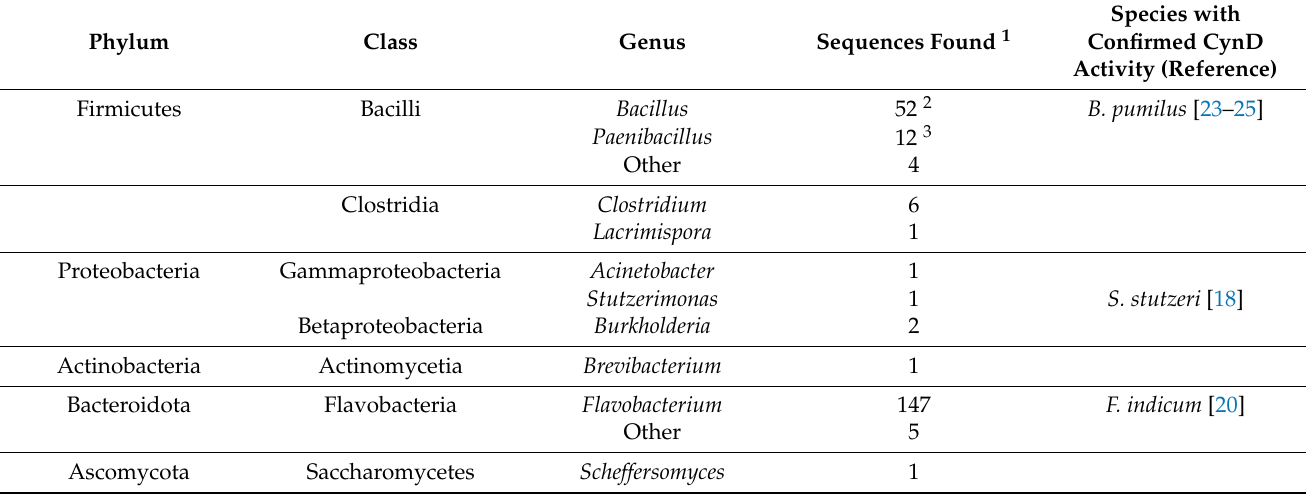
Table 1. Cyanide dihydratases (CynDs) identified in